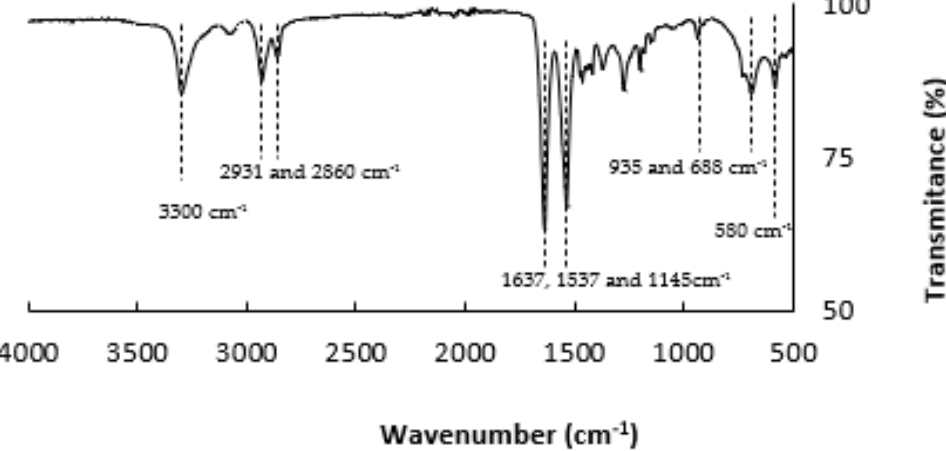
Figure 3. Fourier transform infrared spectra of electrospun PA nanofibres.